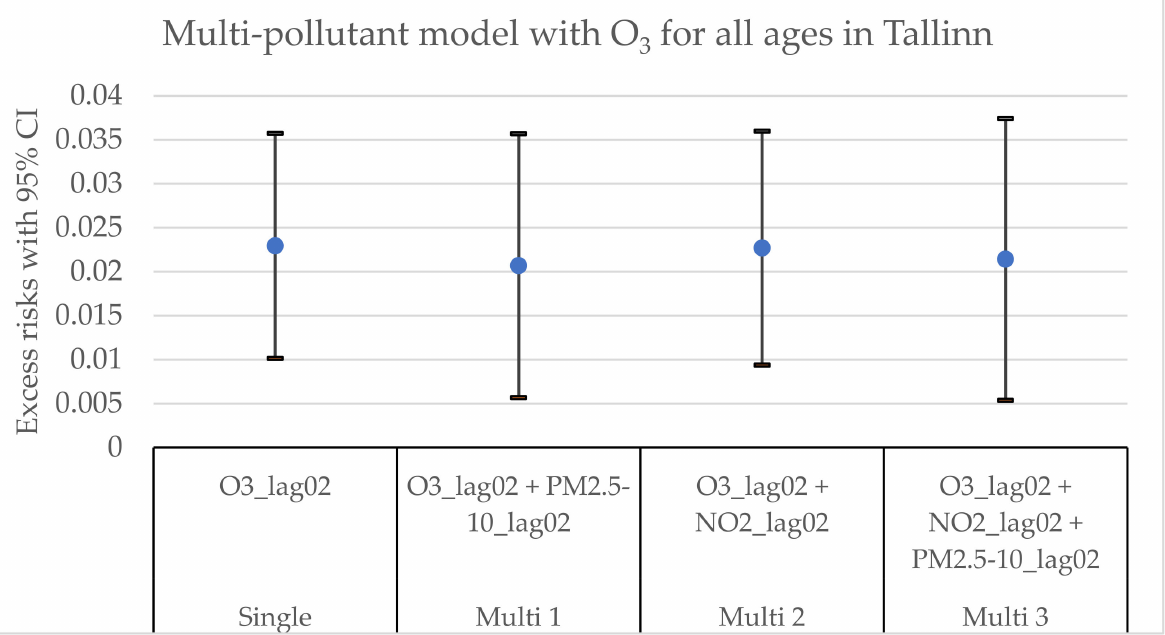
Figure A7. Multi-pollutant models of the estimated change in daily mortality in all ages (with 95% CI) for an IQR increase in the concentration of O 3 (lag02) in Tallinn. From left to right: a single-pollutant estimate of O 3 (Single), O 3 adjusted for PM 2.5–10 (Multi 1), O 3 adjusted for NO 2 (Multi 2), and O 3 adjusted for both NO 2 and PM 2.5–10 (Multi